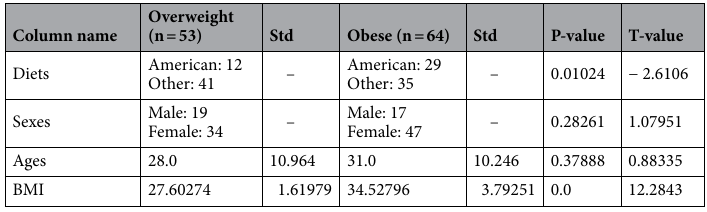
Table 1. Clinical characteristics.